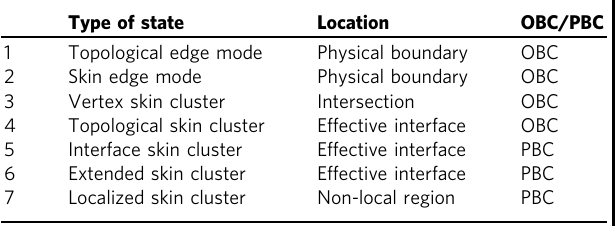
Table 1 Characterization of non-Hermitian skin clusters. The 7 types of boundary states of our two-boson hopping model H in Eq.(1), with the 5 types of unconventional states (3 –